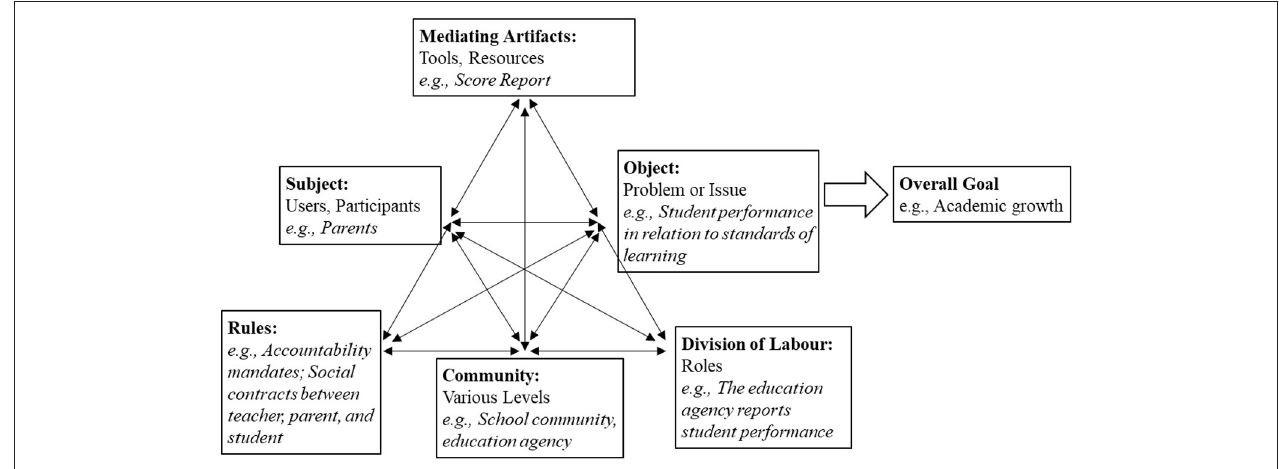
FIGURE 1 | An activity system following Engestrom